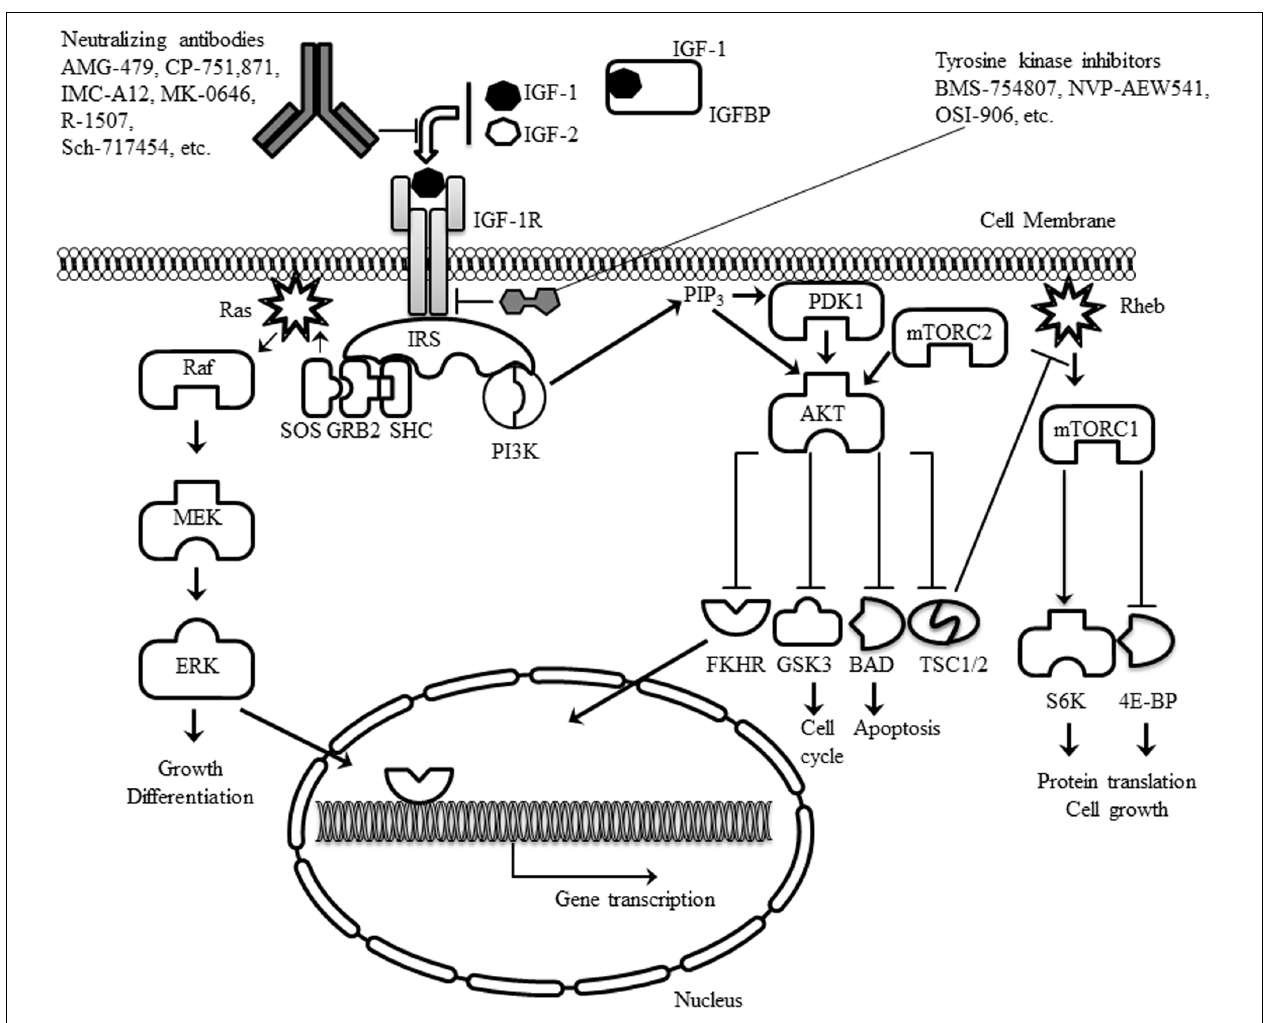
FIGURE 1 | Schematic representation of the IGF-1R, its ligands and the main intracellular signaling pathways activated. The two main classes of experimental drugs against the receptor (antibodies and tyrosine kinase inhibitors) are also